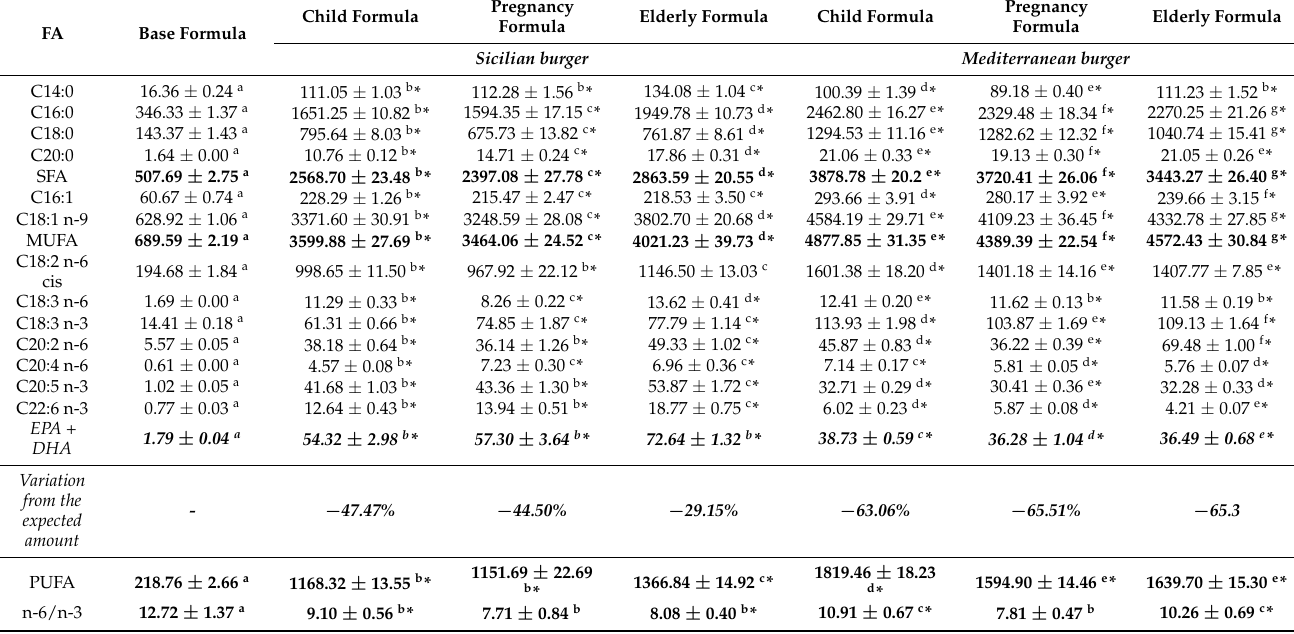
For control and treated burgers: different superscript letters in the same row indicate significantly different values for a given parameter ( p < 0.05 by post hoc Tukey’s HSD test); the same superscript letters in the same row indicate not significantly different values for a given parameter ( p > 0.05 by post hoc Tukey’s HSD test). For a given fortification formula: * indicates significantly different values between Sicilian and Mediterranean burgers ( p < 0.05 by Student’s t